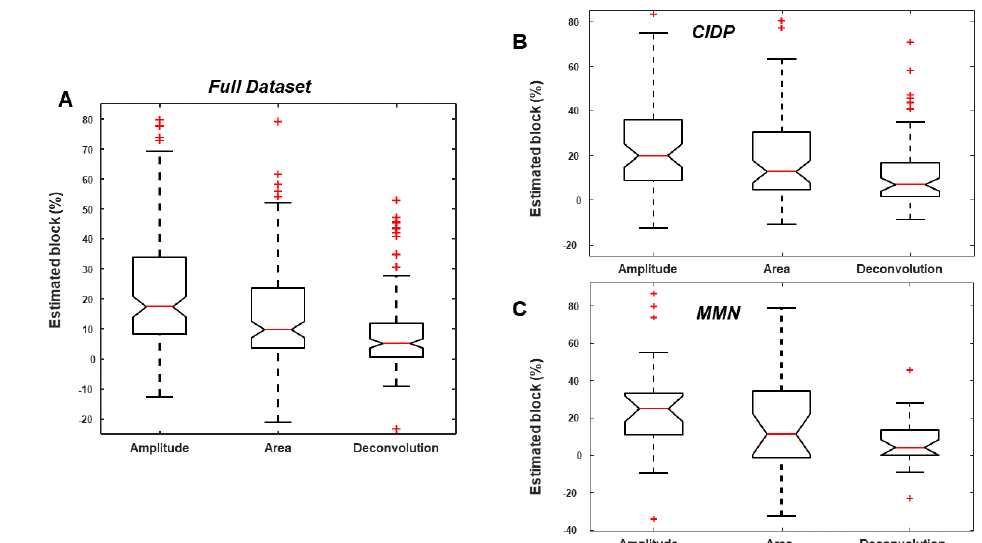
Figure 6. Analysis of variance of CB estimates obtained with standard and deconvolution methods on our dataset. Two way ANOVA on the full dataset indicated a significant difference between methods and pathology. ( A ) CB estimated by amplitude, area and deconvolution on the entire dataset (shown as box and whiskers plots, indicating outliers as red + ). Panel ( B ) same as panel ( A ), but focusing on CIDP patients. ( C ) CB estimations on MMN